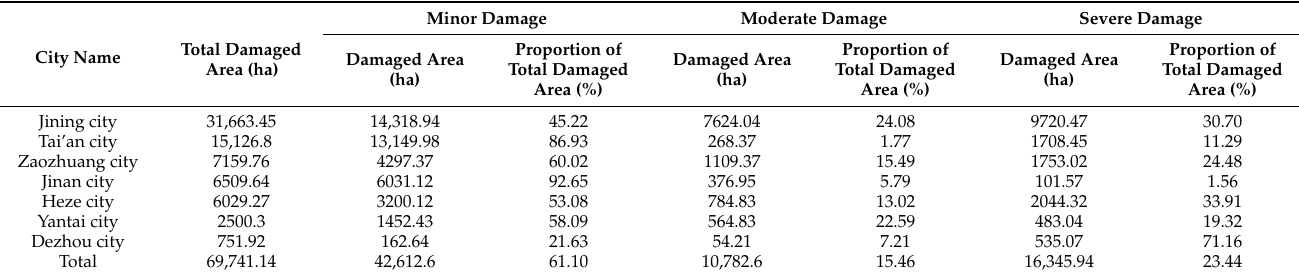
Table 5. Prediction of damaged farmland area by 2025 in COA.